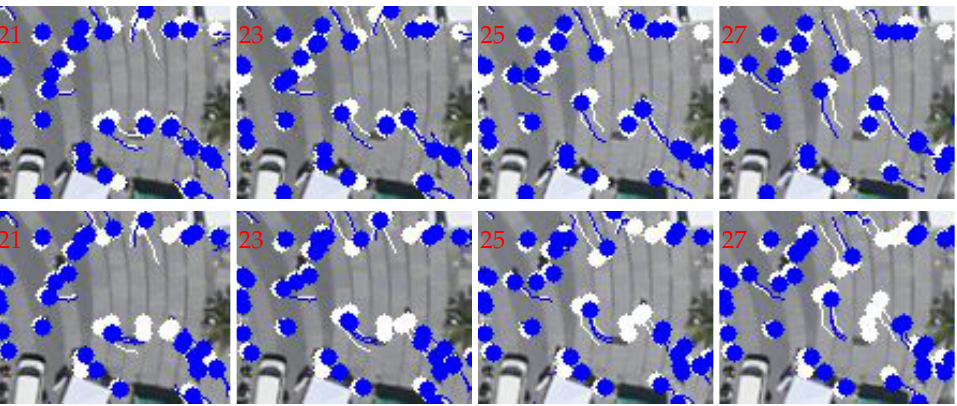
Figure 16. Tracking results by the AerialMPTNet ( top row ) and SMSOT-CNN ( bottom row ) on the frames 21, 23, 25, and 27 of the “Karlsplatz” sequence of the AerialMPT dataset. The predictions and ground truth are depicted in blue and white,